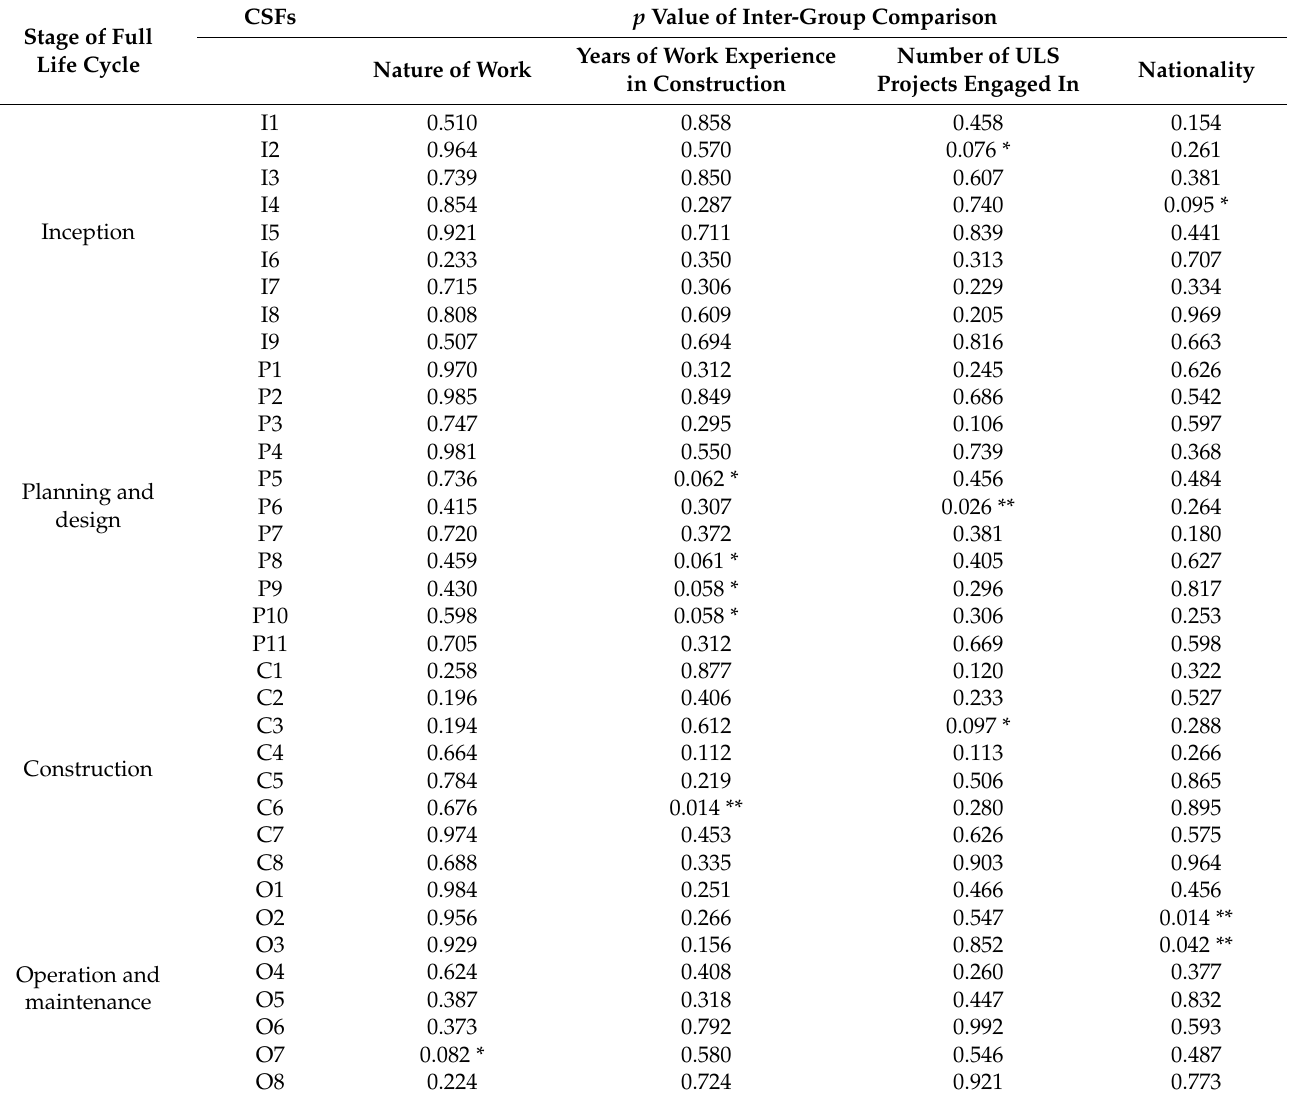
Table 6. Inter-group comparison of the perceived significance of